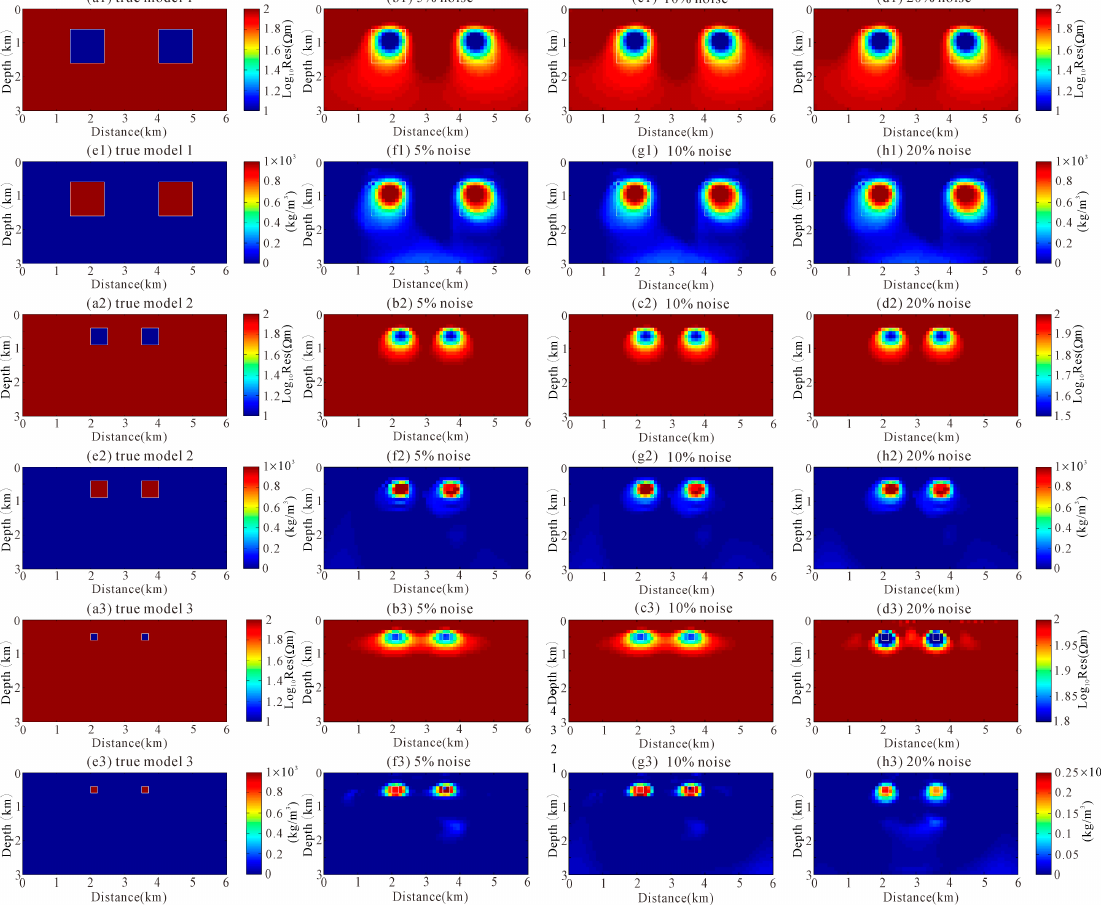
Figure 9. The MT and gravity inversion results obtained using elastic-net joint inversion. Resistivity